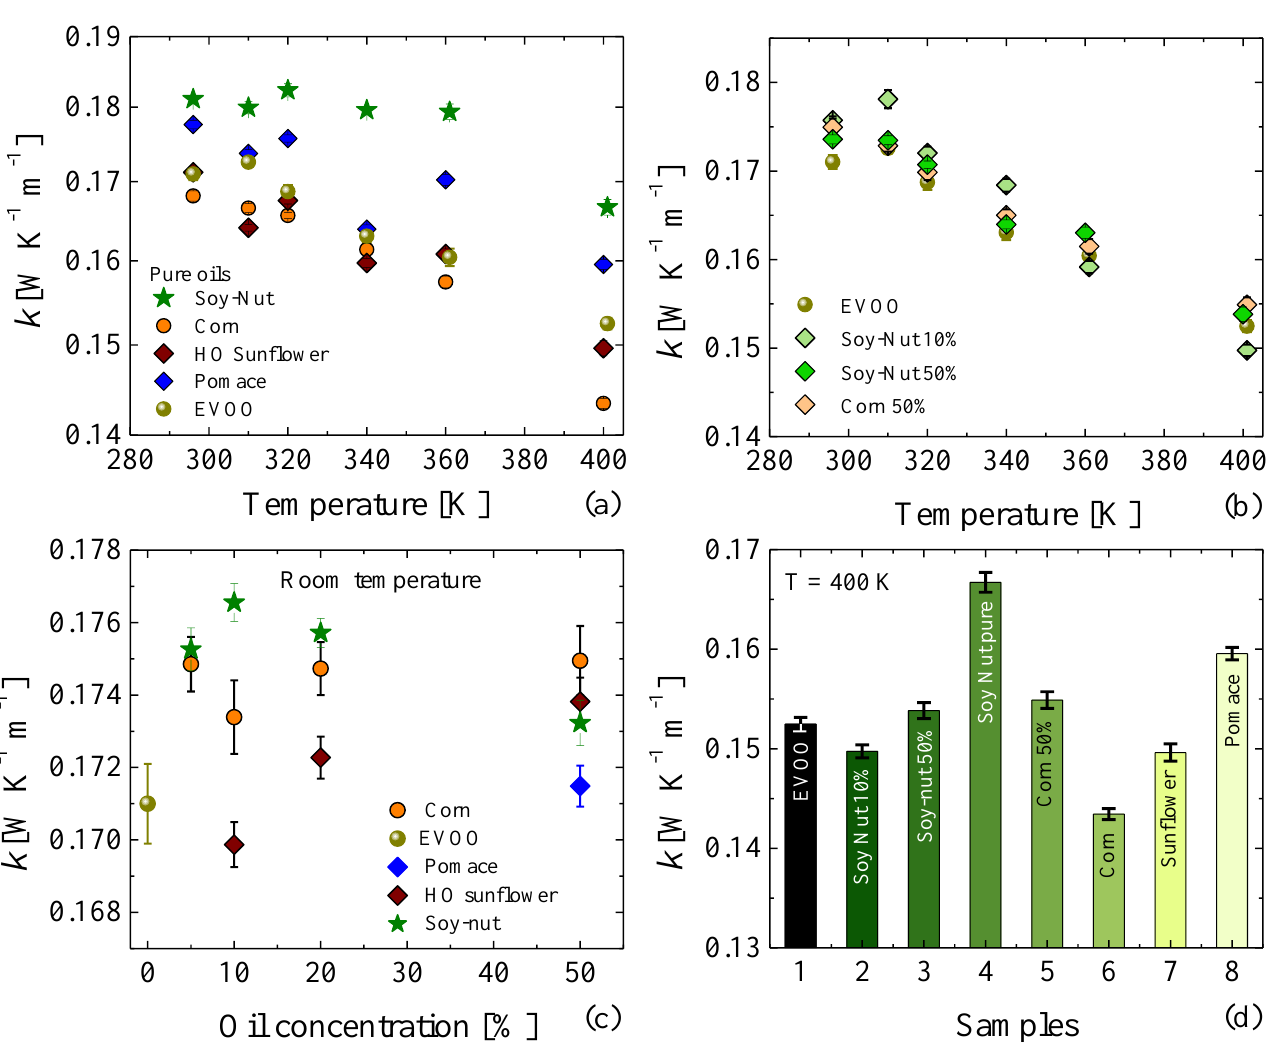
Figure 7. ( a ) Thermal conductivity of pure oils as a function of temperature. ( b ) Thermal conductivity of adulterated oils as a function of temperature. ( c ) Room-temperature thermal conductivity as a function of adulterant oil concentration. ( d ) Comparison of the thermal conductivity at 400 K for different pure oils or adulterated EVOO.